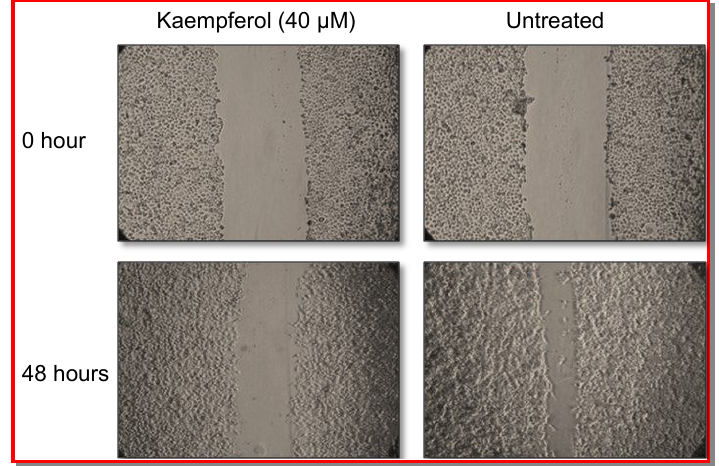
Figure 3: Effects of kaempferol on the migration of non-small cell lung cancer cells. A549 cells were either treated with 40 µM of kaempferol or left untreated (control) for 24 hours and the wound healing was observed after 48